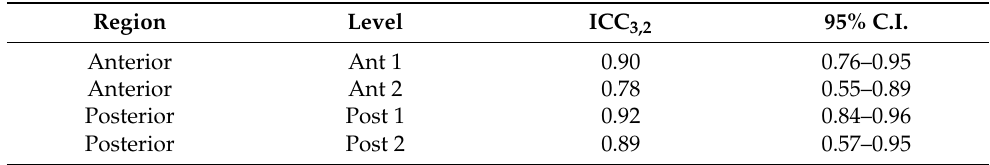
Table 9. Intra-rater reliability of the ultrasound measurements within different regions/levels of the superficial fascia of the forearm between two sessions by